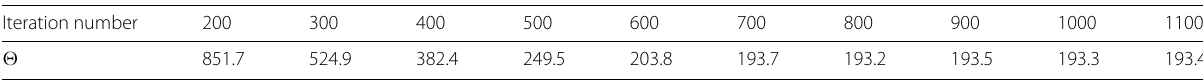
Table 5 The objective value ( × 10 3 ) decreases as the number of iteration increases, and it converges when the number of iteration reaches 700 Iteration